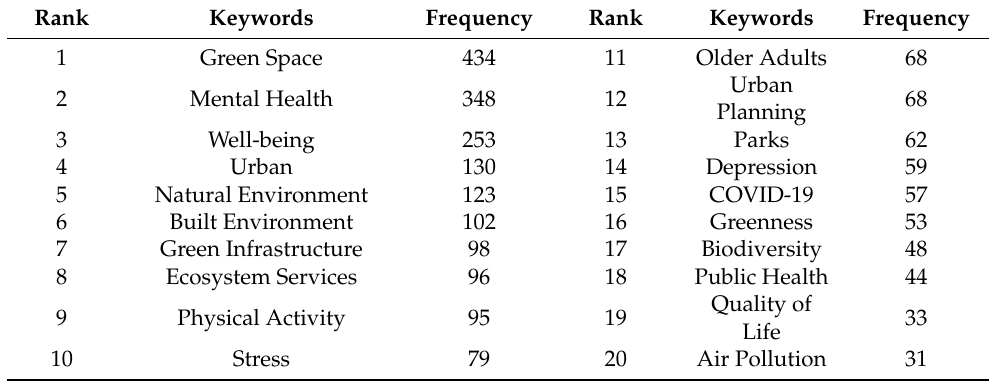
Table 3. Top 20 keywords for the study of green space and senior mental health.